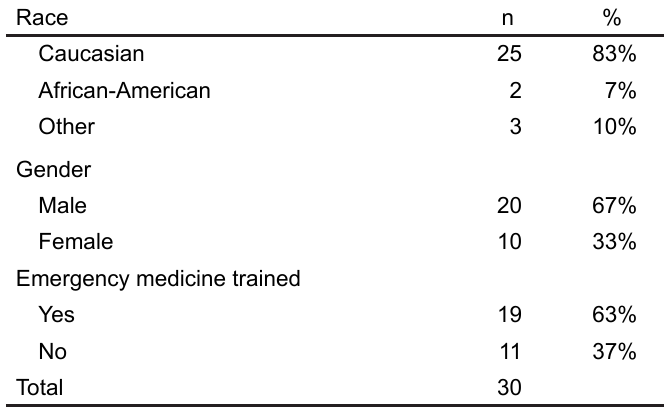
Table 4. Attending physician characteristics (n=30).